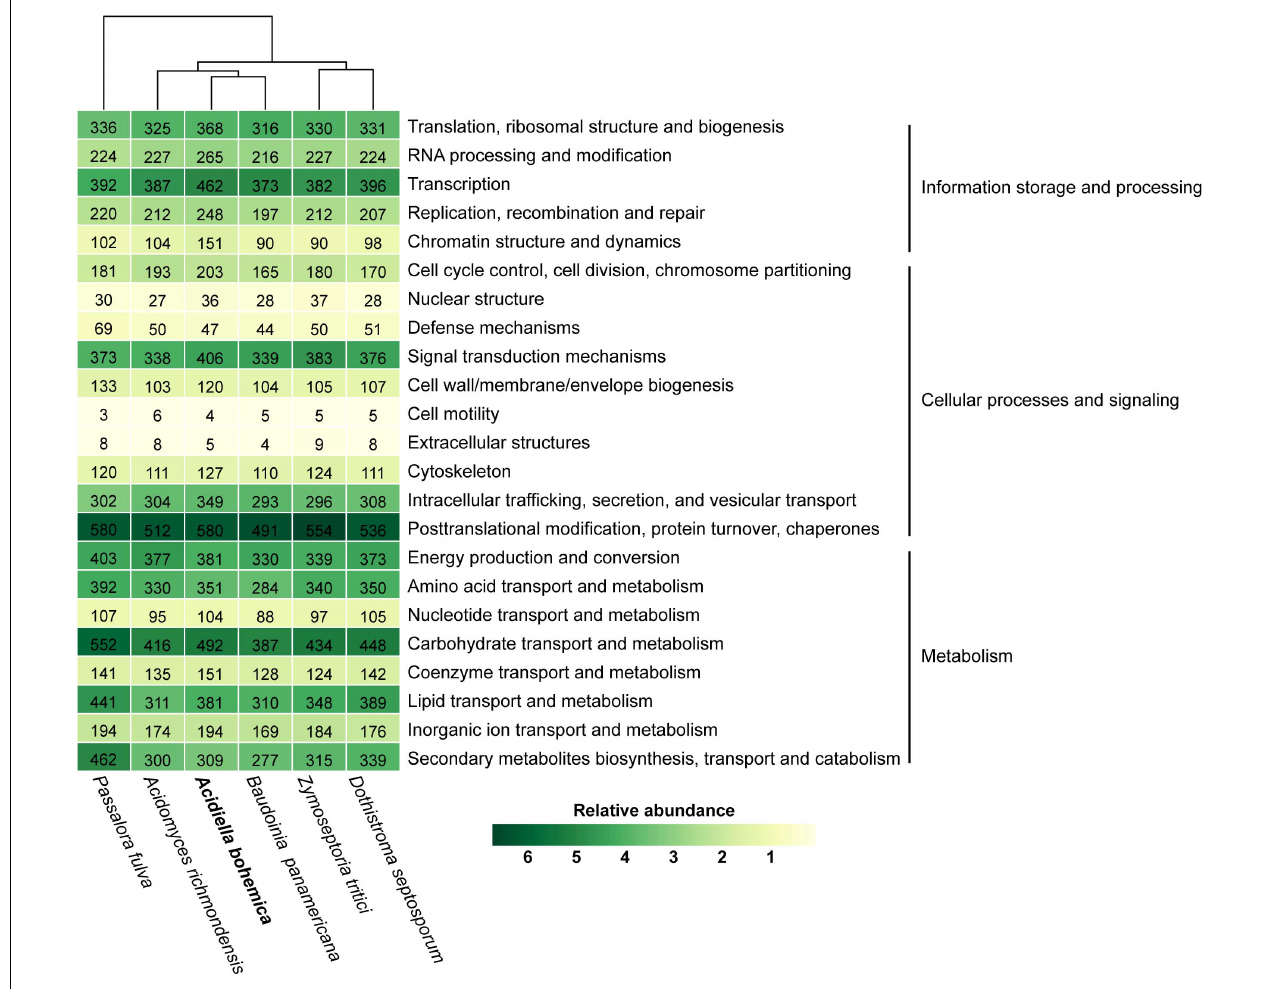
FIGURE 3 | KOG classification of A. bohemica and five related fungi. Hierarchical clustering and heat map colors are based on percentage out of total number of proteins identified in the genome. The absolute number of proteins is given as